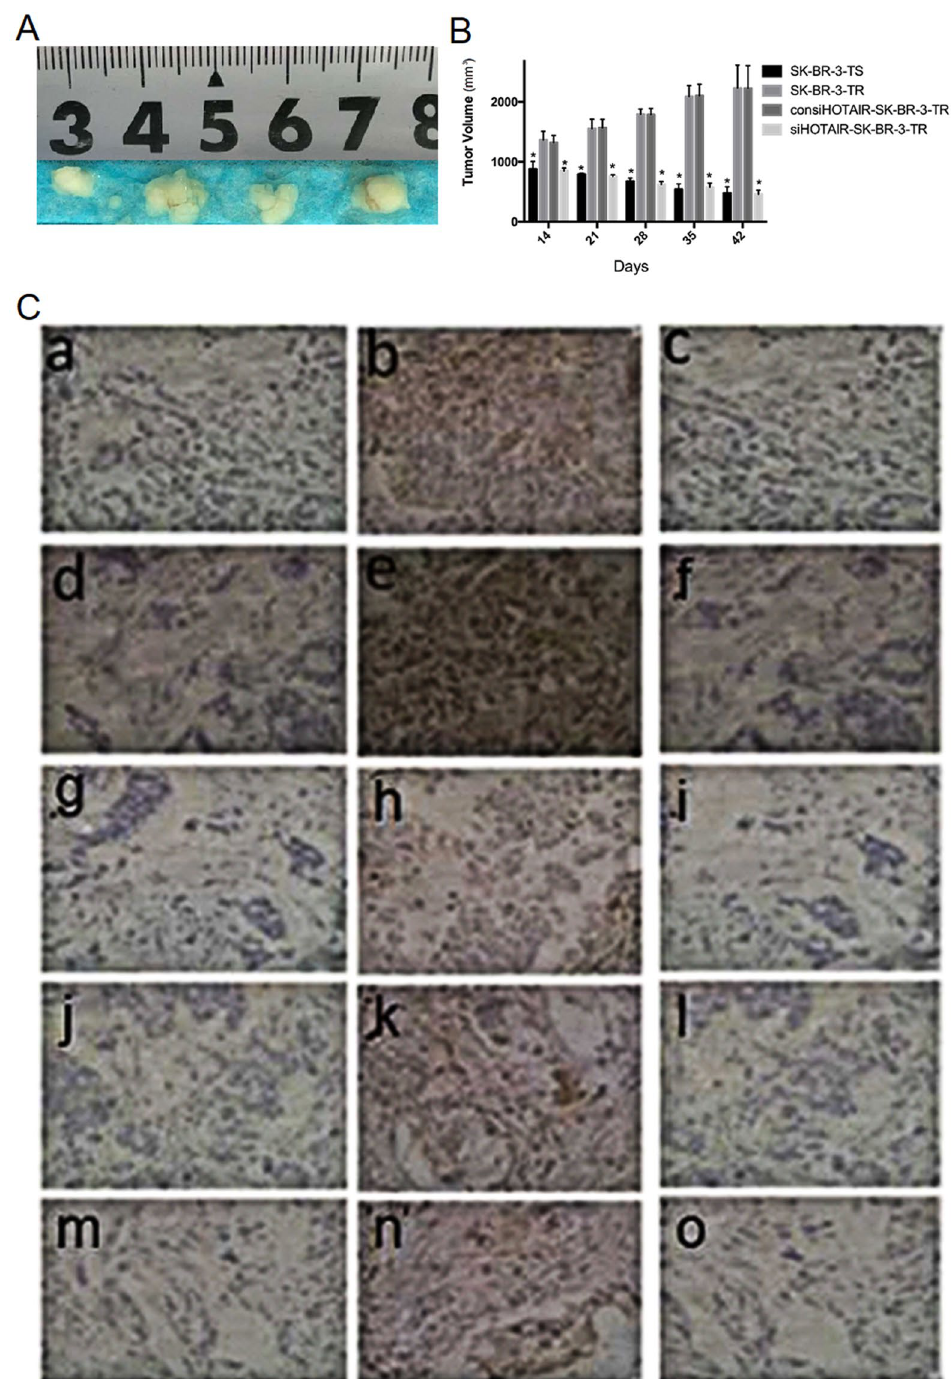
Figure 9. Tumors developed after trastuzumab intervention in mice injected with different breast cells (from left to right, derived from SK-BR-3-TS, SK-BR-3-TR, con siHOTAIR-SK-BR-3-TR and siHOTAIR-SK-BR- 3-TR cells) and expression of EMT and HER2 pathway-related proteins in the tumors (IHC, x 200). ( A ) tumor morphology (n = 6), ( B ) average tumor volume, ( C ) immunohistochemical analysis. a and c: Snail − ; b: Snail + ; d and f: Ki67 − ; e: Ki67 + ; g and i: E-cadherin − ; h: E-cadherin + ; j and l: TGF- β− ; k: TGF- β+ ; m and o: PTEN − ; n: PTEN + . * P < 0.05 vs